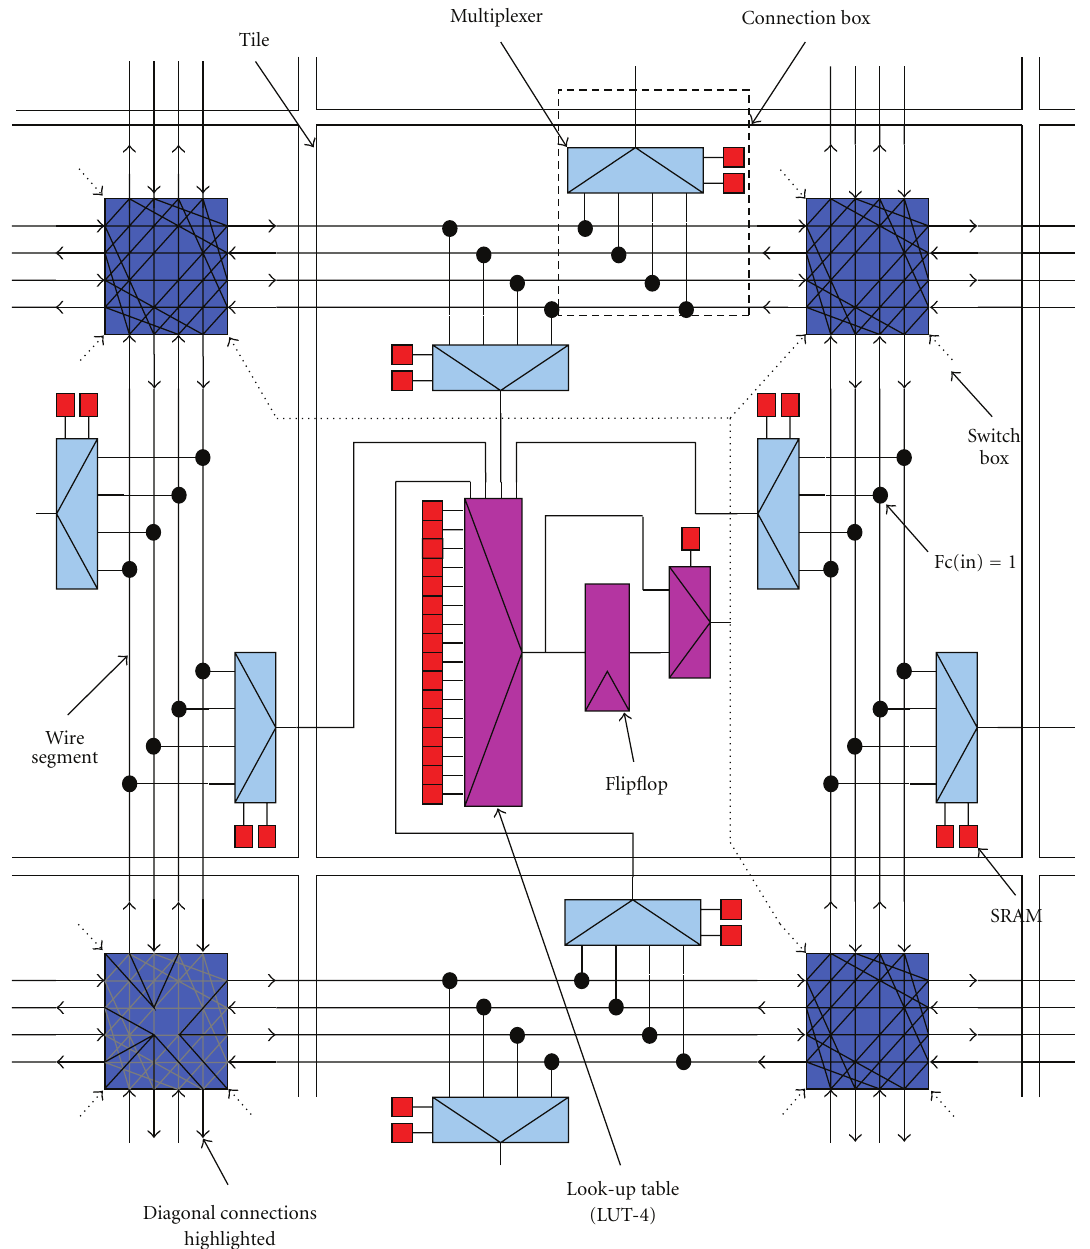
Figure 2: Detailed interconnect of a CLB with its neighboring